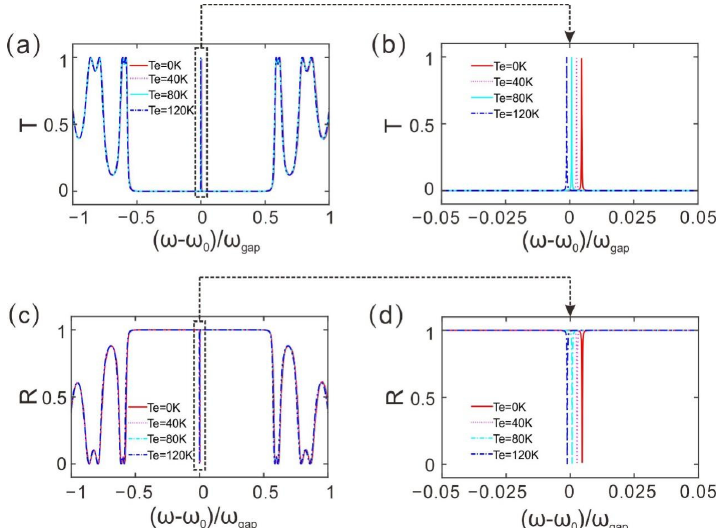
Figure 3. ( a , c ) Transmittance and reflectance, respectively, varying with the normalized frequency at different temperature values. ( b , d ) Local magnifications of local transmittance and reflectance, respectively, varying with the normalized frequency at different temperature values. (The number of periods for N = 4).